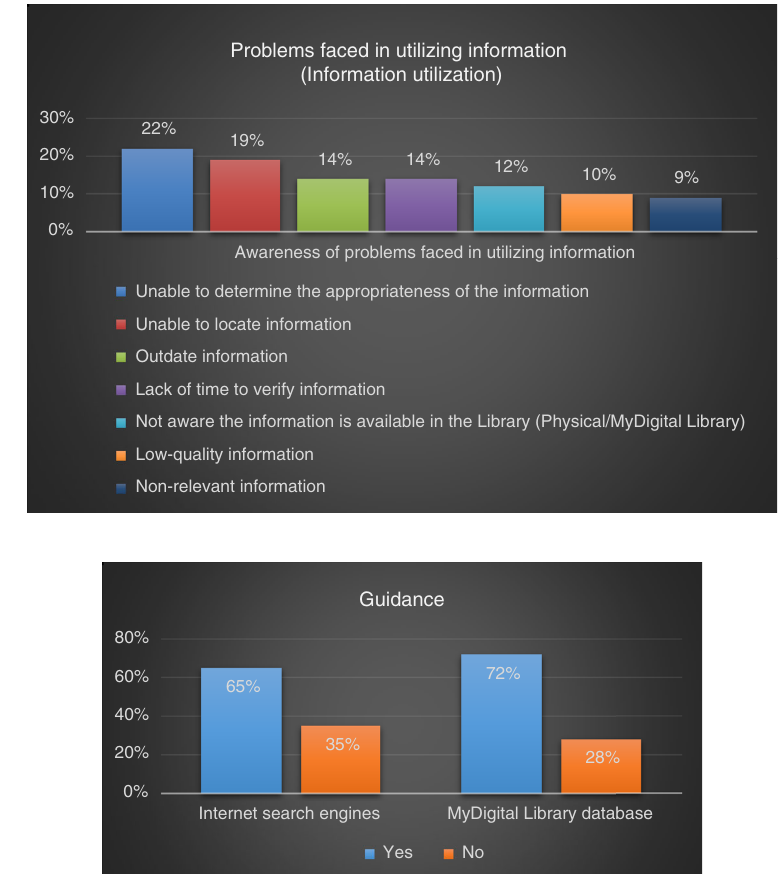
Figure 3. Percentage of respondents who required guidance with online information